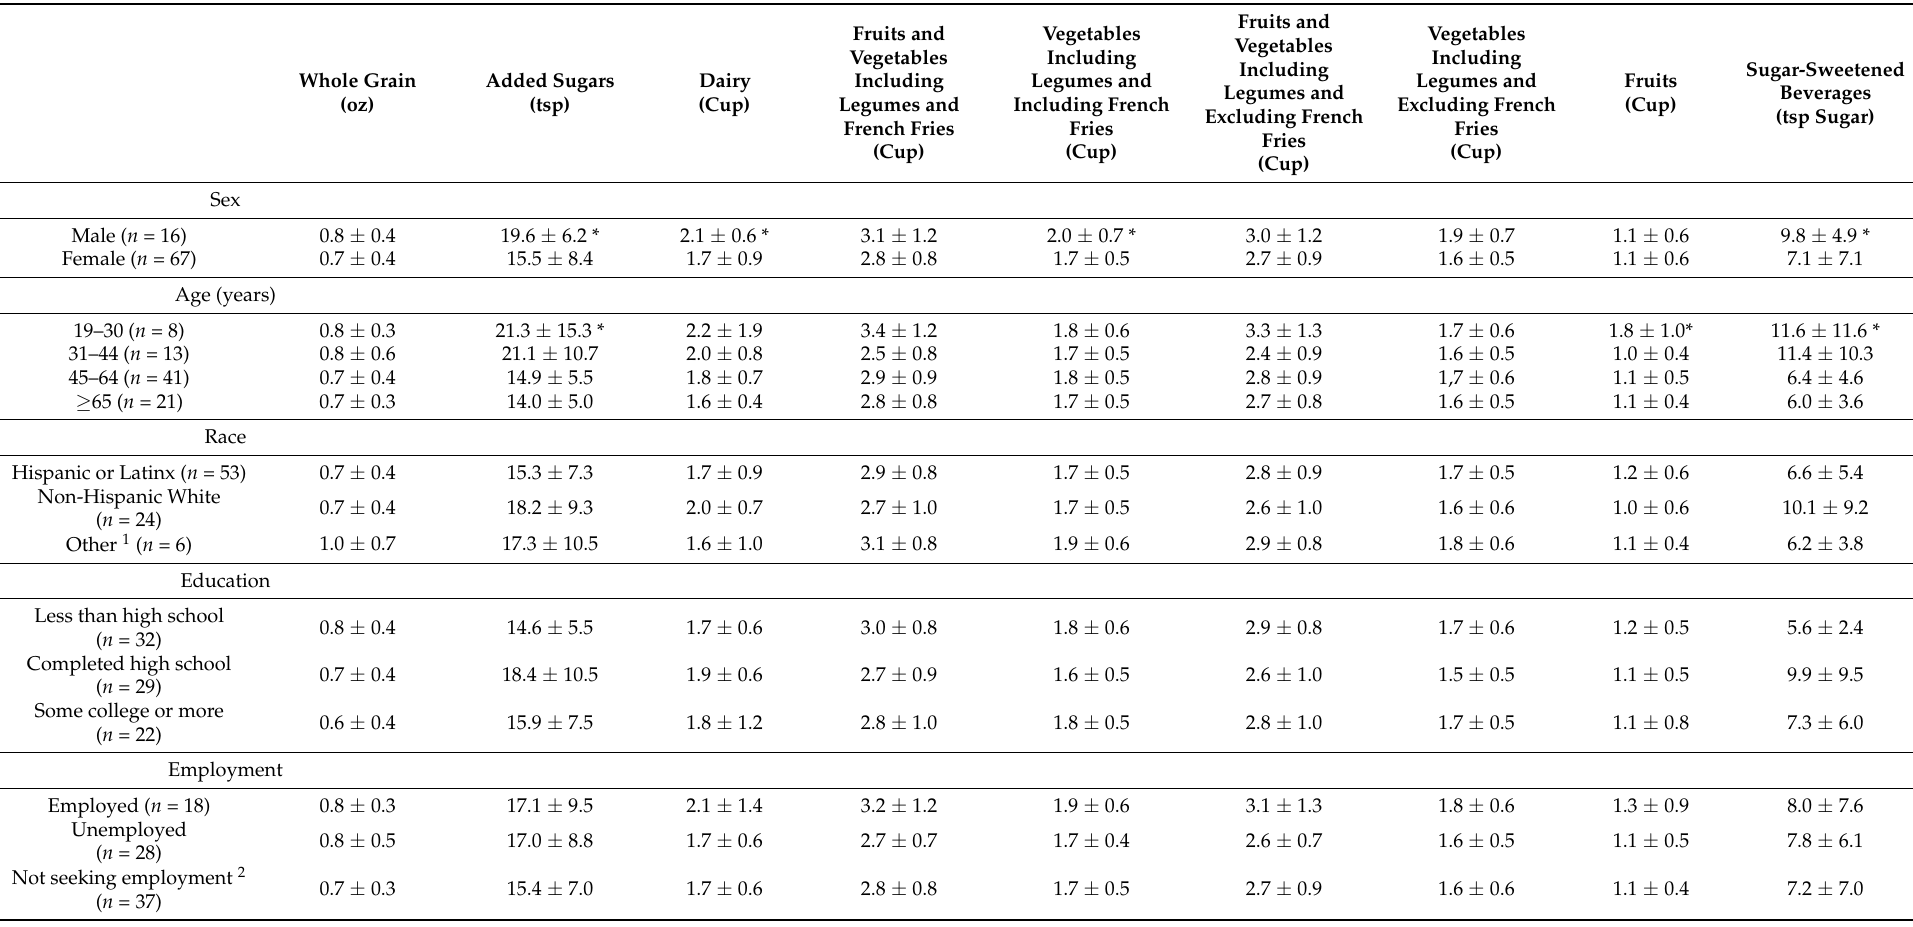
Table 3. Predicted daily intakes of food groups by socioeconomic characteristics based on NCI Dietary Screener Questionnaire in mobile food pantry users in Windham County, CT ( n = 83).